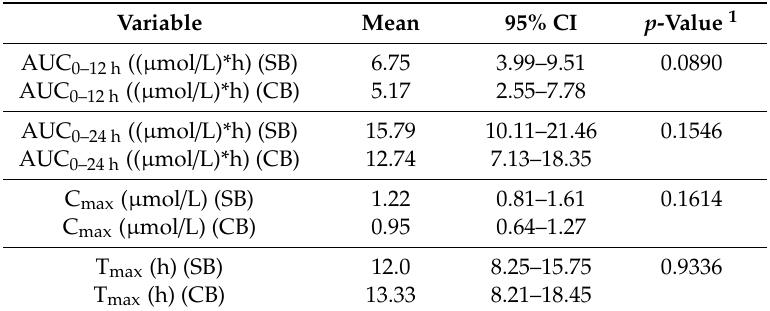
Table 4. Pharmacokinetic parameters of DMG.